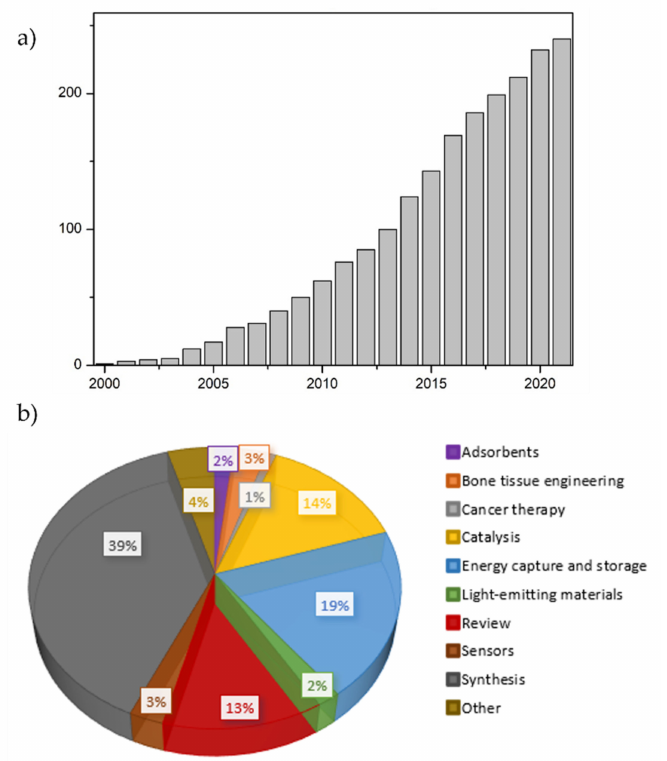
Figure 1. ( a ) Total accumulated number of publications appearing in the Scopus database from 2000 until June 2021 after removing duplicates found through “biotemplating” and “bio-templating” keyword data searching. ( b ) Scope of the different papers on biotemplating appearing in Scopus from 2000 to June